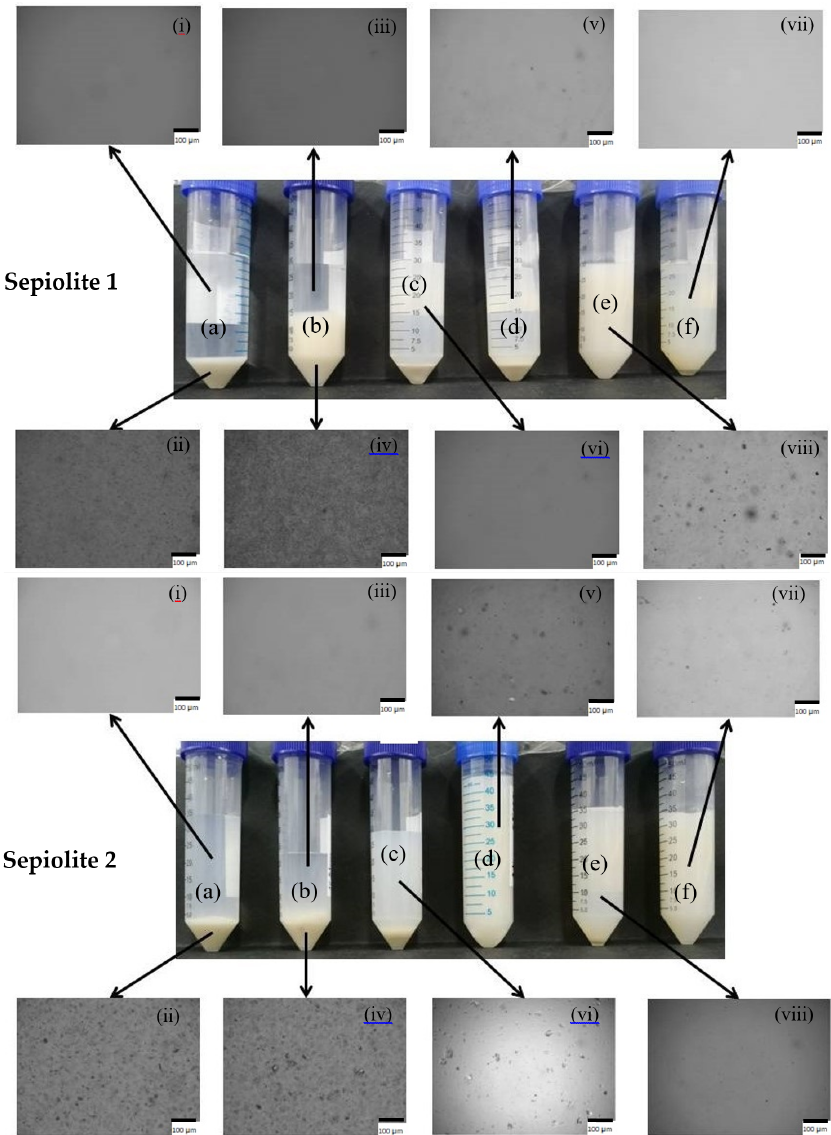
Figure 6. Sepiolite 1 ( top ) and sepiolite 2 ( bottom ) 1.0 wt% aqueous suspensions (pH ca. 8). (a) Magnetically stirred; (b) magnetically stirred with 0.1 wt% polyphosphate; (c) high-shear dispersed; (d) high-shear dispersed with 0.1 wt% polyphosphate; (e) sonicated; (f) sonicated with 0.1 wt% polyphosphate. ( i ) Top phase of suspension (a); ( ii ) bottom phase of suspension (a); ( iii ) top phase of suspension (b); ( iv ) bottom phase of suspension (b); ( v ) suspension (d); ( vi ) suspension (c); ( vii ) suspension (f); ( viii ) suspension (e). The images (photographs and micrographs) were taken 90 days after sample preparation. The scale bar in the insets ( i )–( viii ) represent 100 µ